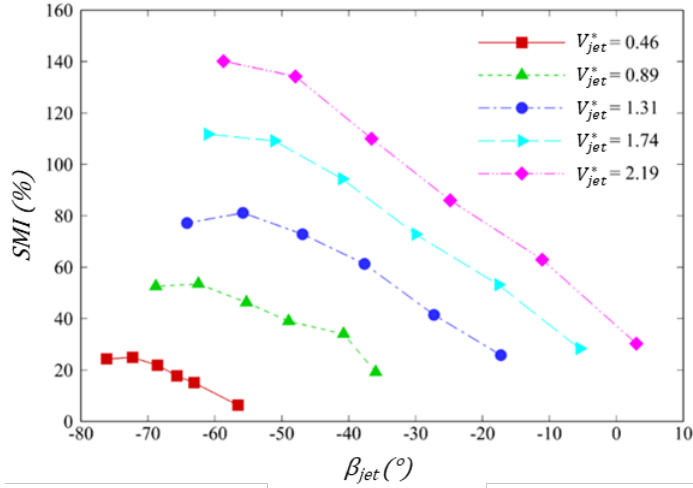
Figure 7. Effect of the relative blowing flow angle with 40 injectors activated for a rotation speed of 3200 rpm.